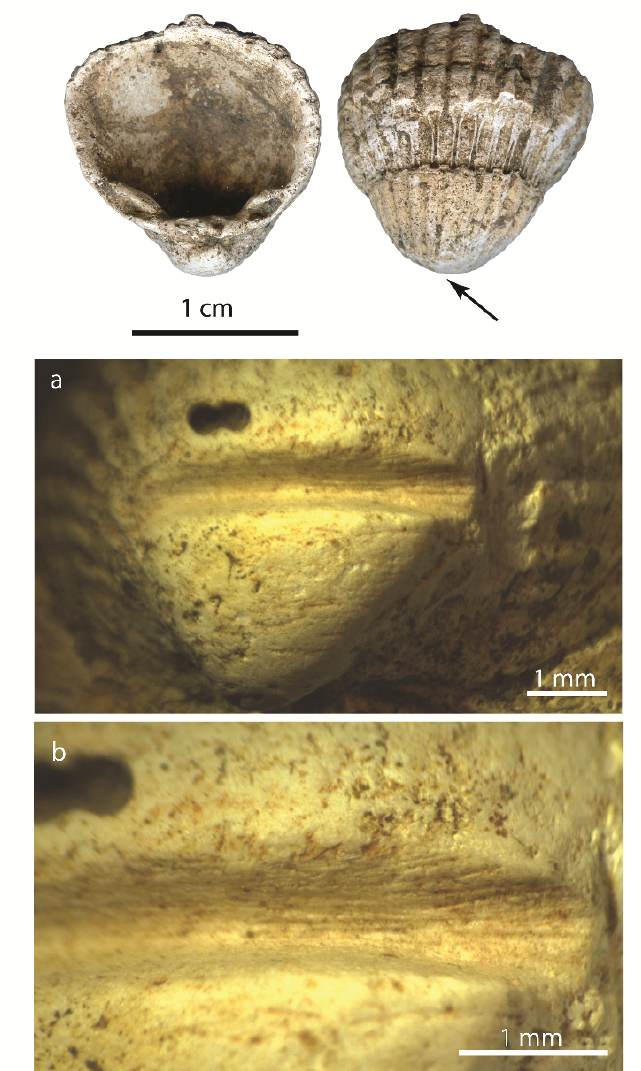
Figure 5: Transversal groove made with a lithic tool observed on the umbo of the Cerastoderma edule from Rochereil (a, b). The perforation has a natural